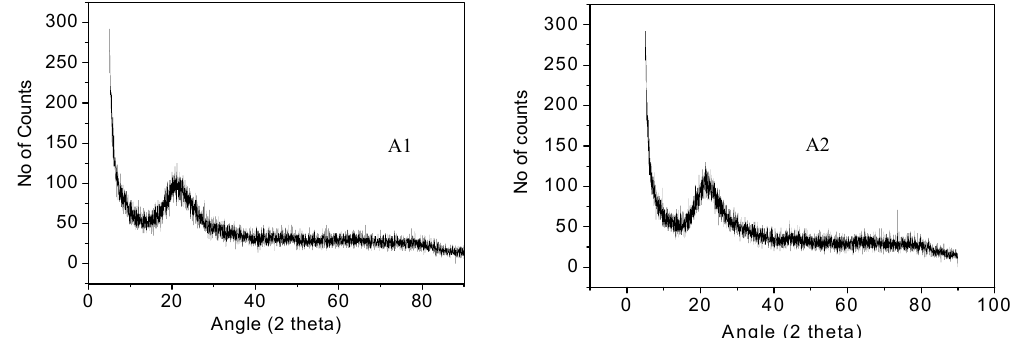
Figure 16. XRD curves of two aluminosilicate-based preform samples of EDF (A1) with Al 2 O 3 4.5 mol% and (A2) with Al 2 O 3 4 mol%.